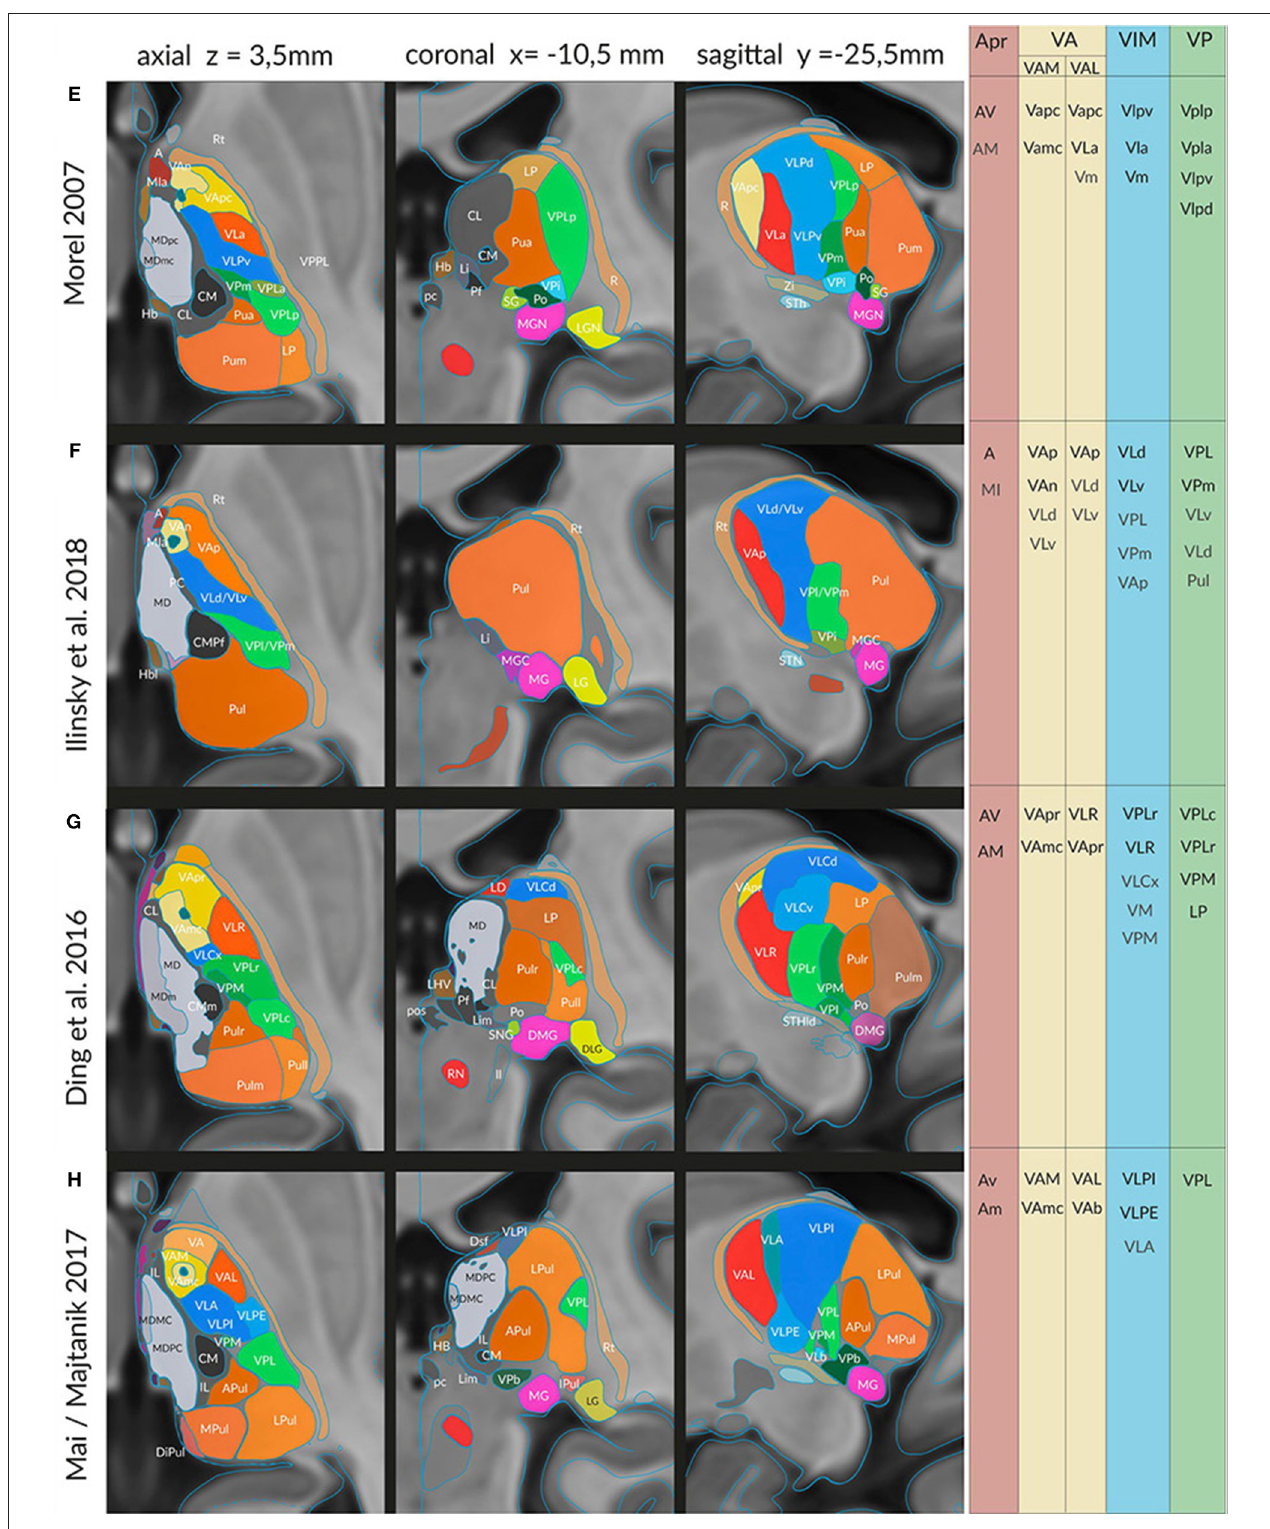
FIGURE 4 | Sections in three cardinal planes from eight different authors indicating segmentations of the thalamus in the common standard (MNI) space: (A) Hassler (1977), (B) Feremutsch and Simma (1971), (C) Van Buren and Borke (1972), (D) Percheron (2004), (E) Morel (2007), (F) Ilinsky et al. (2018), (G) Ding et al. (2016) and (I) Mai and Majtanik (2017). The exact positions of the three cardinal planes are indicated in the upper line. The color code is the same as in the preceding figures. Right side: areas or nuclei that have been selected for the clusters representing the nigral, pallidal (yellow), cerebellar (blue), sensory (green) territories, and the anterior thalamic nucleus. For abbreviations see Supplementary Table 2